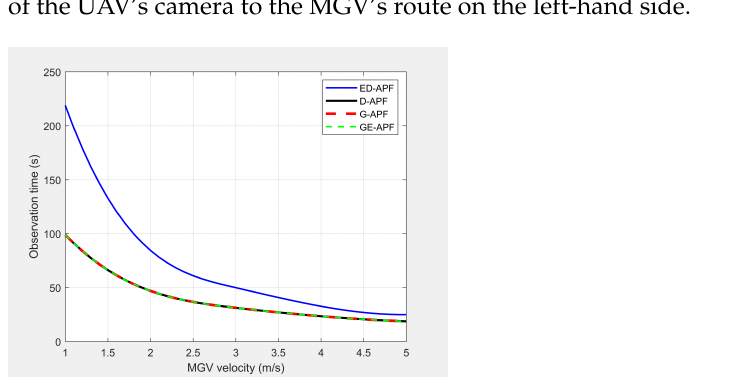
Figure 29. Comparison of the observation time for different velocities of the MGV.